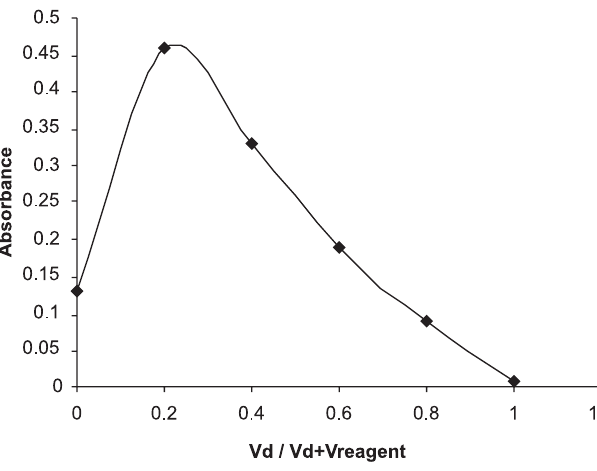
FIGURE 9 - Job’s continuous variations